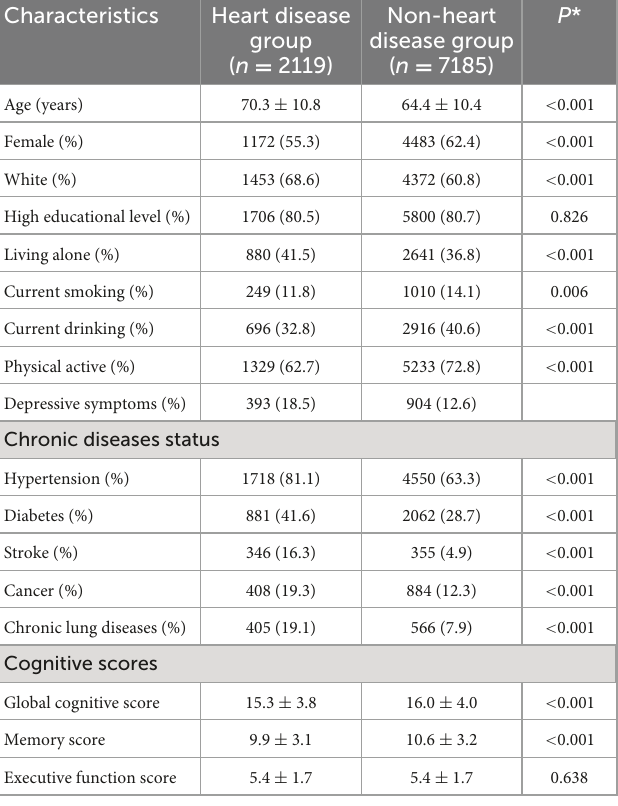
TABLE 1 Baseline characteristics of included participants, by heart diseases status.